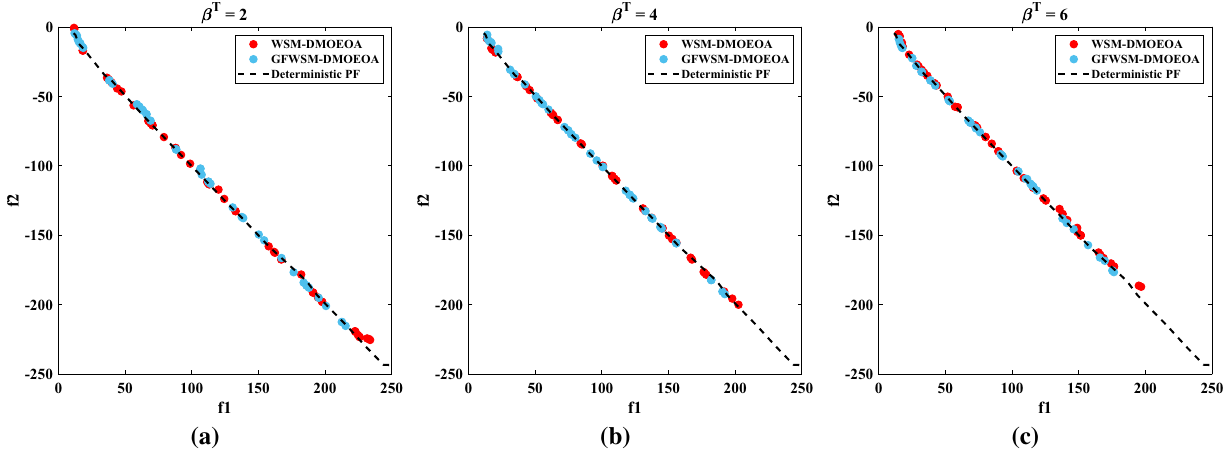
Fig. 8 The best Pareto optimal fronts obtained by WSM-DMOEOA, GFWSM-DMOEOA and DMOEOA on MORBDO test example 1 under different target reliability